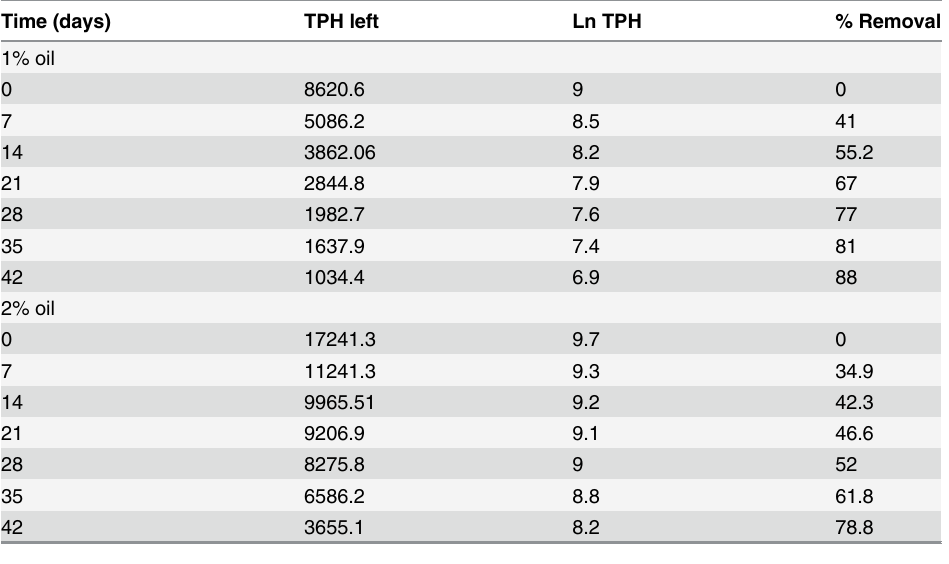
Table 2. Data for kinetic studies of remediation.